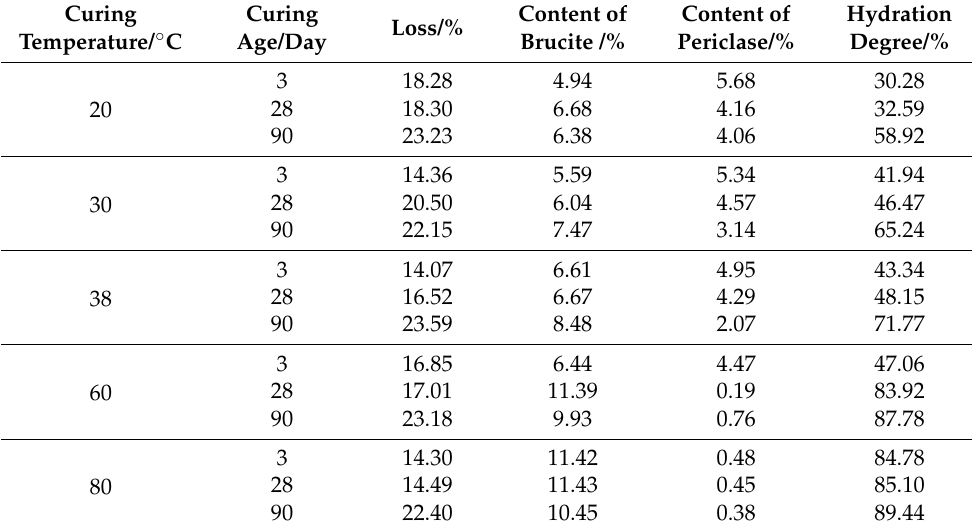
Table 6. The hydration degree of MgO (190 s) in cement paste.